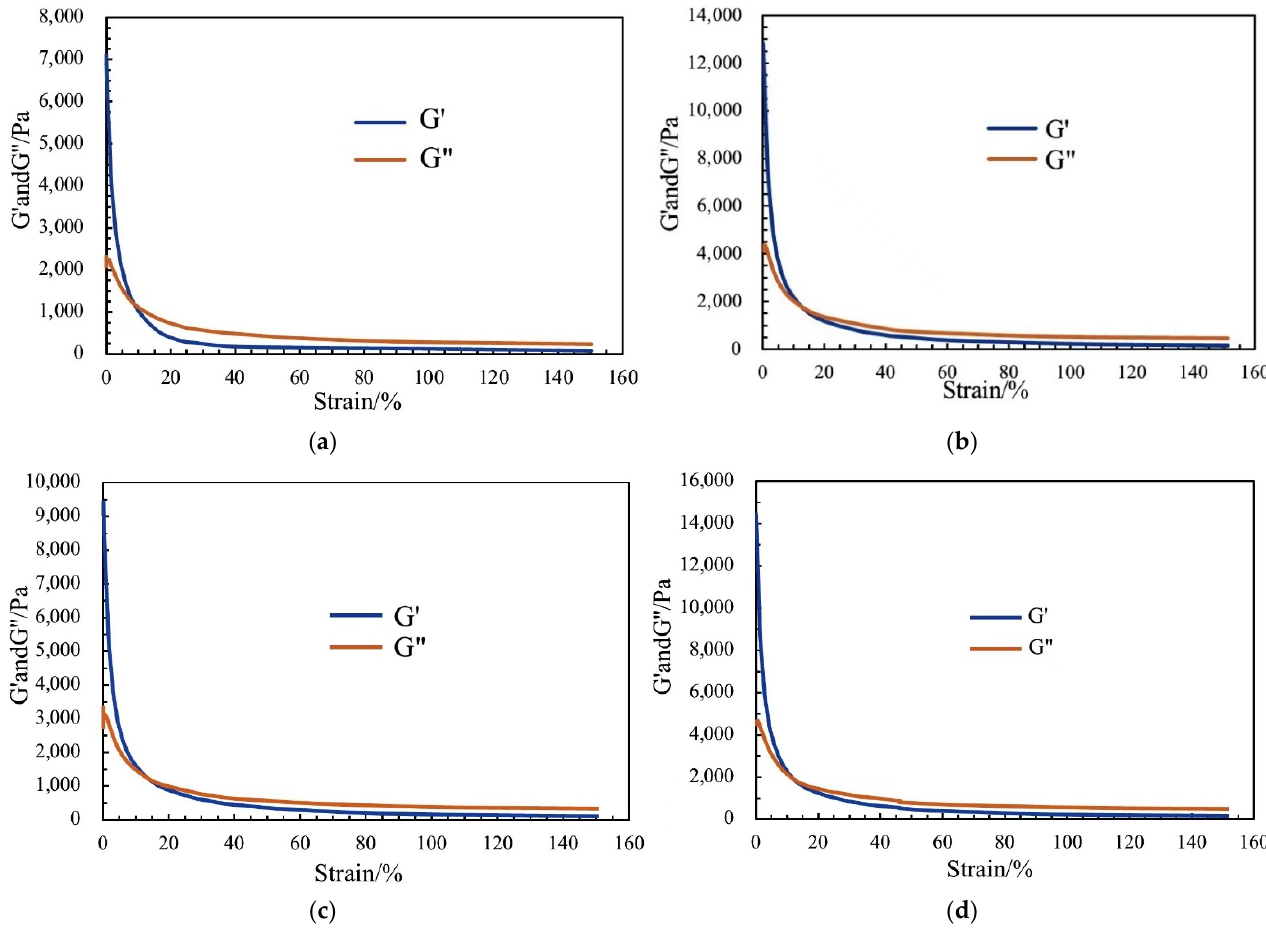
Figure 9. Grease modulus curve: ( a ) PTFE; ( b ) Graphene; ( c ) CNTs; ( d ) WS 2 .